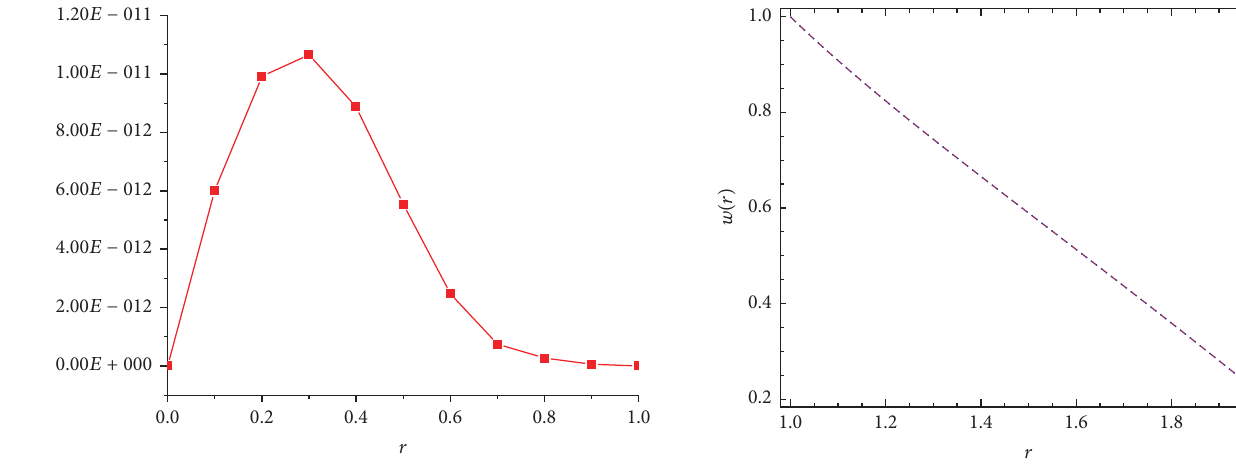
= 0.001032981 , and 3